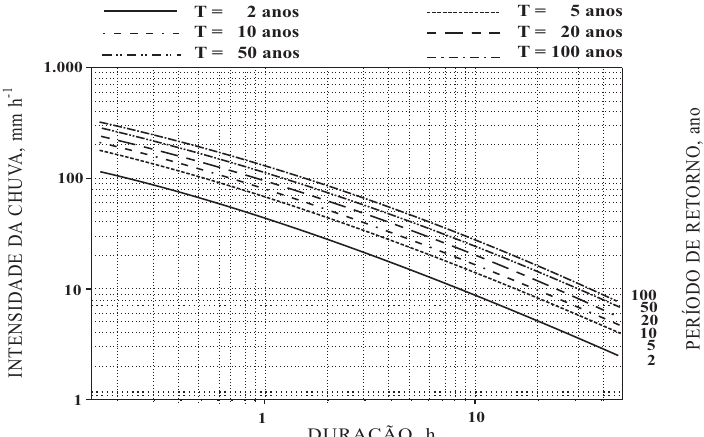
Figura 3. Períodos de retorno esperados (T), em anos, da chuva em Quaraí-RS, como variável da intensidade e duração das